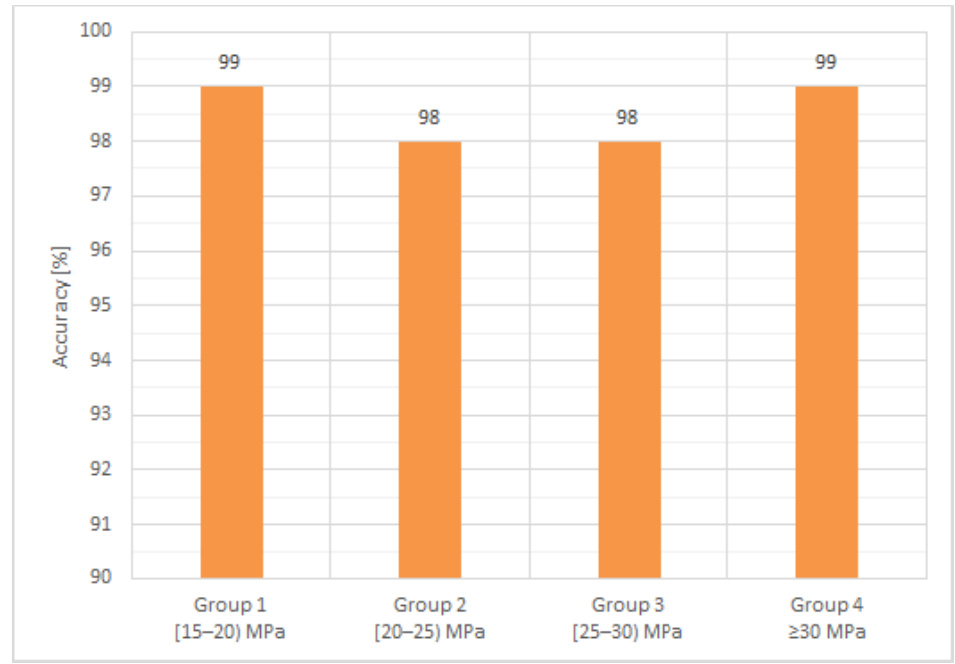
Figure 5. Air-dry density, the accuracy of the NDT method with respect to the reference.